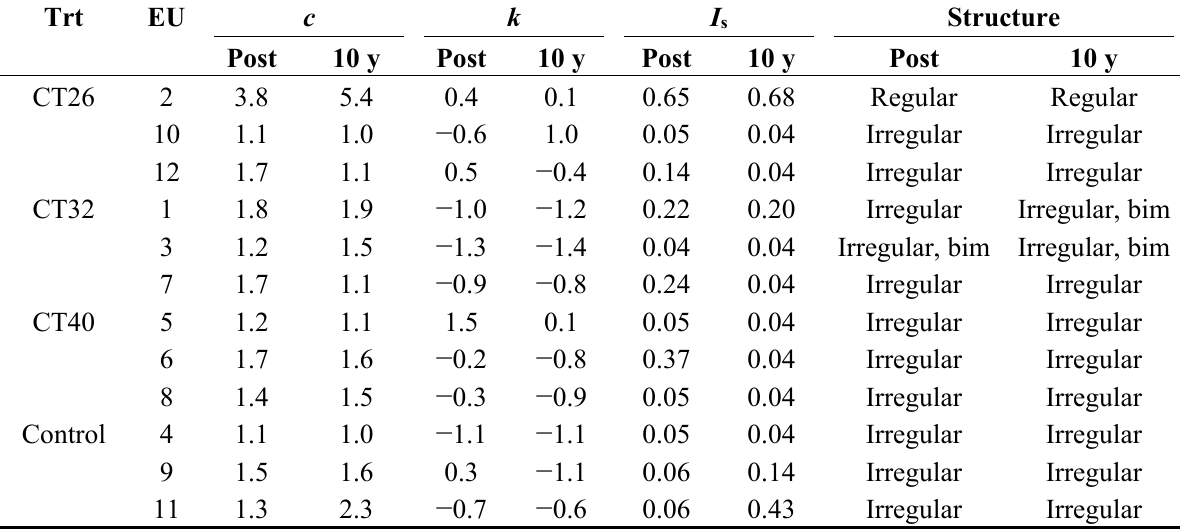
Table 3. Statistical parameters and structure of the diameter distribution of all trees (DBH >1.0 cm) for each experimental unit (EU) immediately postharvest (post) and after 10 years according to: the Weibull function ( c ), the coefficient of kurtosis ( k ), the symmetry index ( I s ) and the interpretation of the structure. Abbreviations: bim, bimodal distribution; trt, thinning treatment.